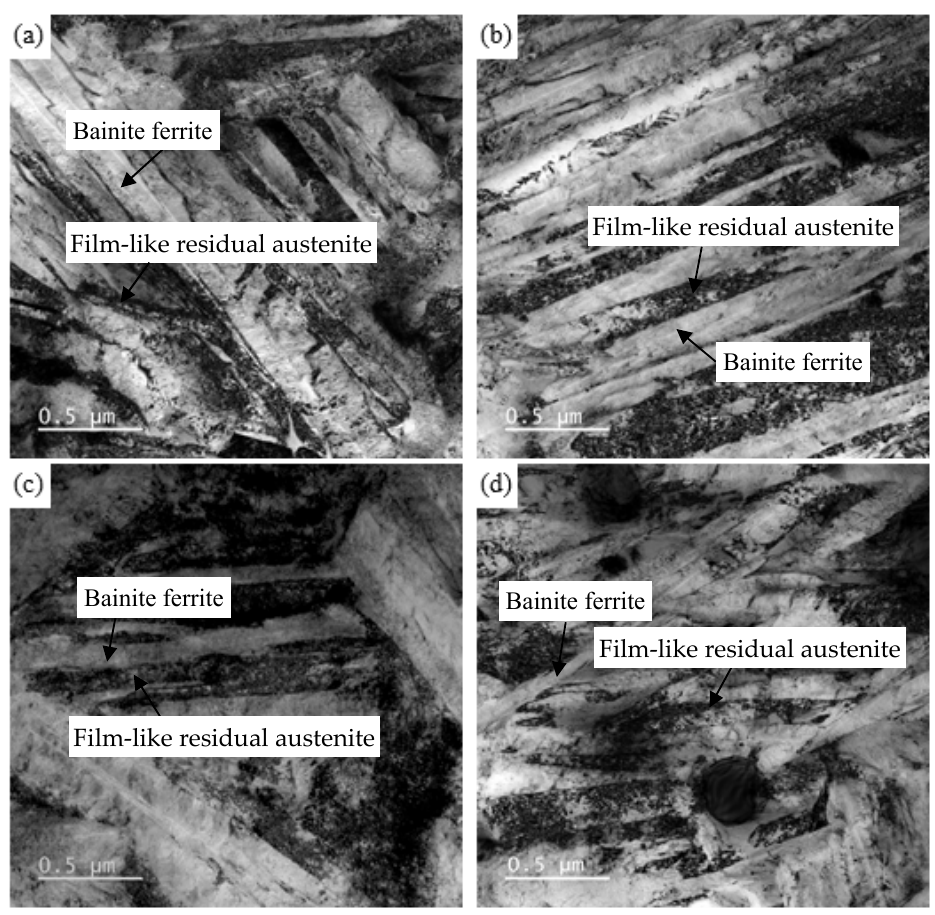
Figure 8. TEM micrographs of the steels austempered at different temperatures for 8 h: ( a ) GCr15SiMo at 210 °C; ( b ) GCr15Si1Mo at 210 °C; ( c ) GCr15SiMo at 230 °C; ( d ) GCr15Si1Mo at 230 °C.